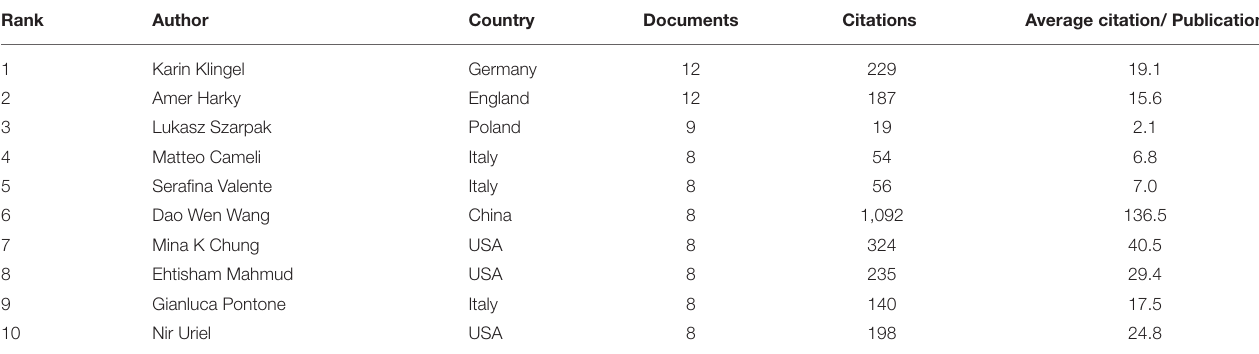
TABLE 3 | Detailed information of the top ten